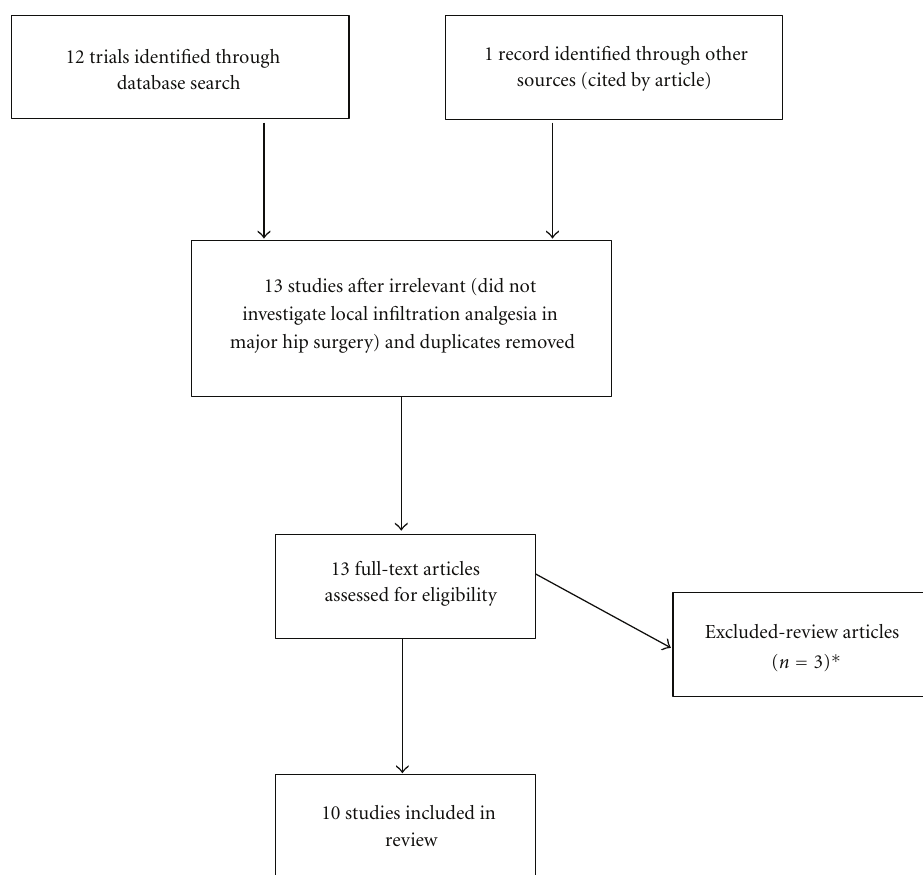
Figure 1: Flow diagram of exclusion of clinical trials for review